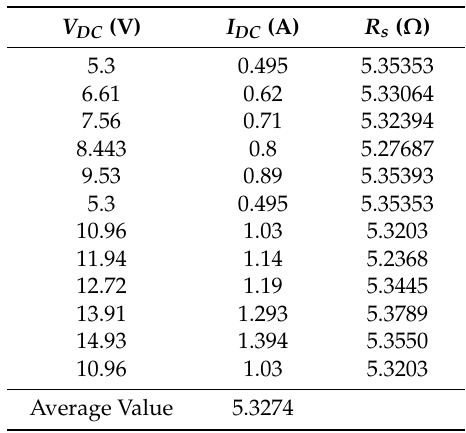
Table 2. DC test results.